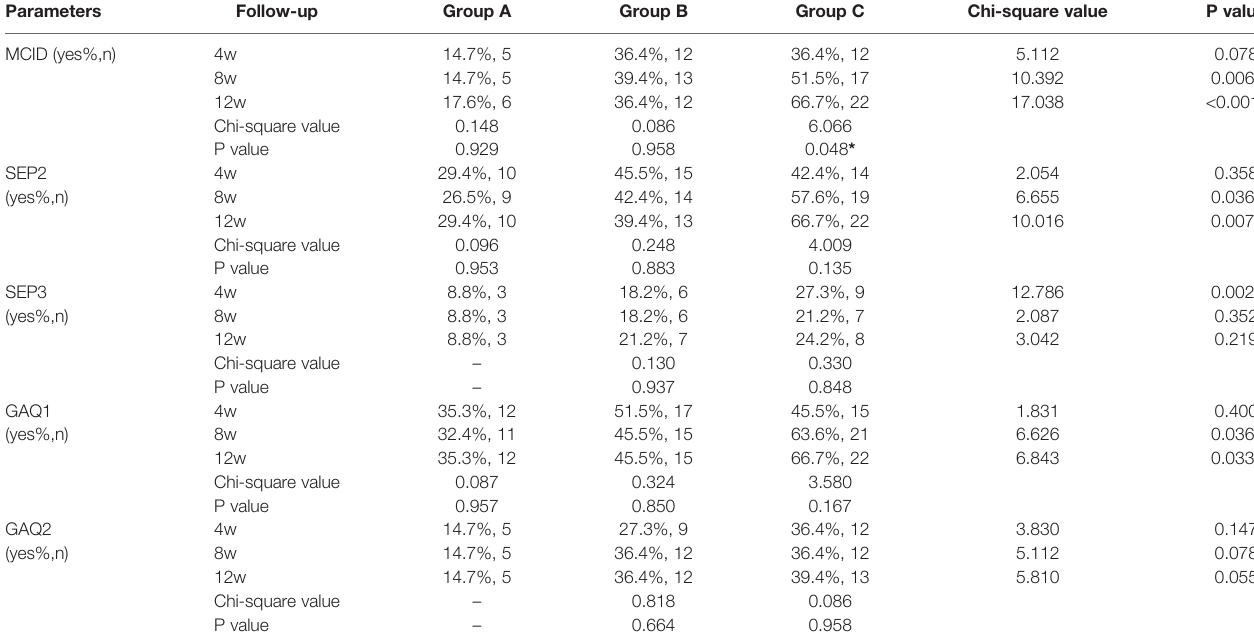
TABLE 2 | The differences of parameters of therapeutic ef fi cacy among three groups and within each group at various follow-up points.